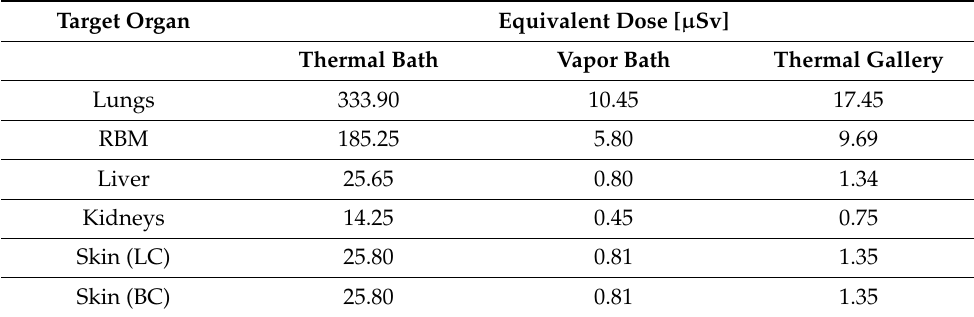
Table 4. Selected organ-specific equivalent doses for lungs, red bone marrow (RBM), liver, kidneys, and skin, resulting from the inhalation of radon progeny in the thermal bath, vapor bath, and thermal gallery, based on the dose conversion coefficients of Kendall and Smith [25], considering differences in breathing rates, exposure times, equilibrium factors, and unattached fractions. Lung doses were calculated with the IDEAL-DOSE model [19,39] and doses to Langerhans cells (LC) and basal cells (BC) in the skin with the inhalation dose coefficients of Brudecki et al. [24]. Target Organ Equivalent Dose [ µ Sv] Thermal Bath Vapor Bath Thermal Gallery Lungs 6.74